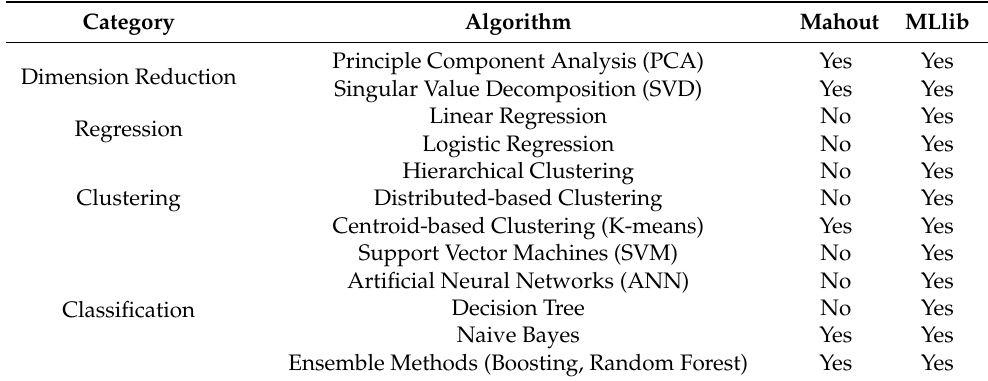
Table 8. Implemented Algorithms of Mahout and